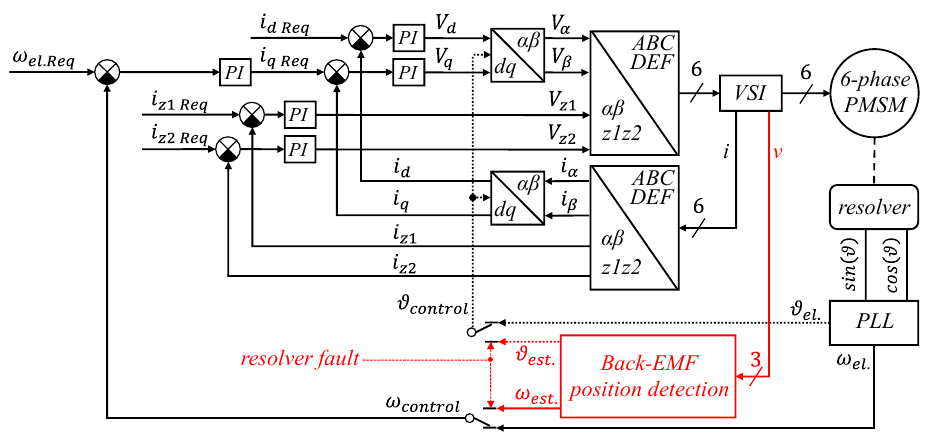
Figure 1. Field-oriented control structure with the vector space decomposition method, and emer- gency detection of the rotor speed/position.